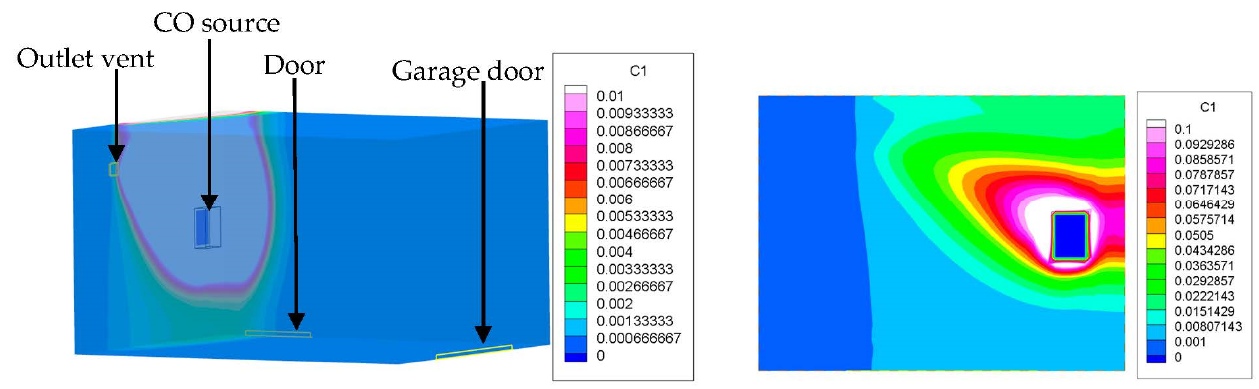
Figure 4. CO distribution in the garage—case 1 (concentration of CO in kg/kg).